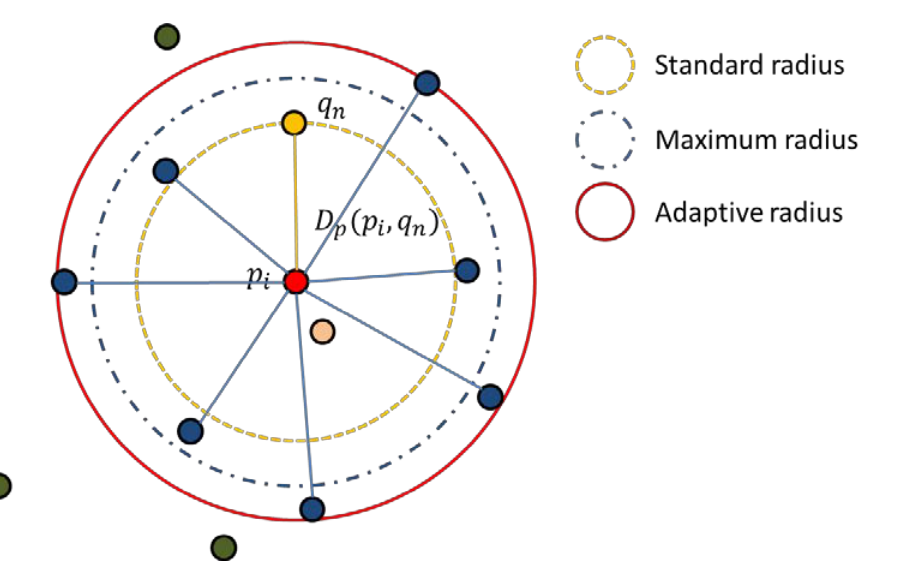
Figure 1. Schematic diagram of adaptive radius selection.